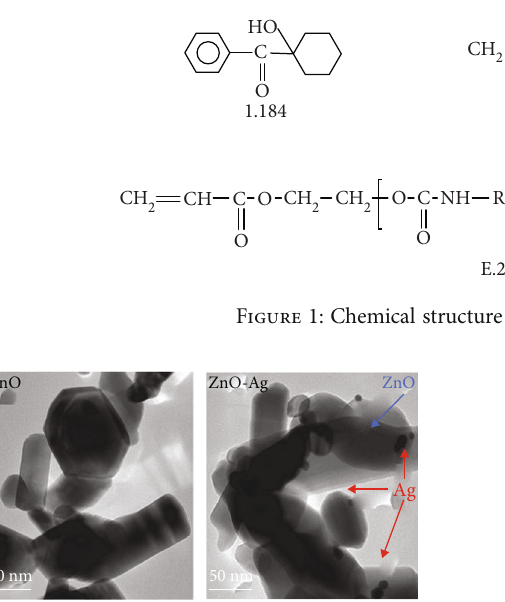
Figure 2: TEM images of pure ZnO nanoparticles (ZnO) and self- synthesis ZnO-Ag nanohybrids.